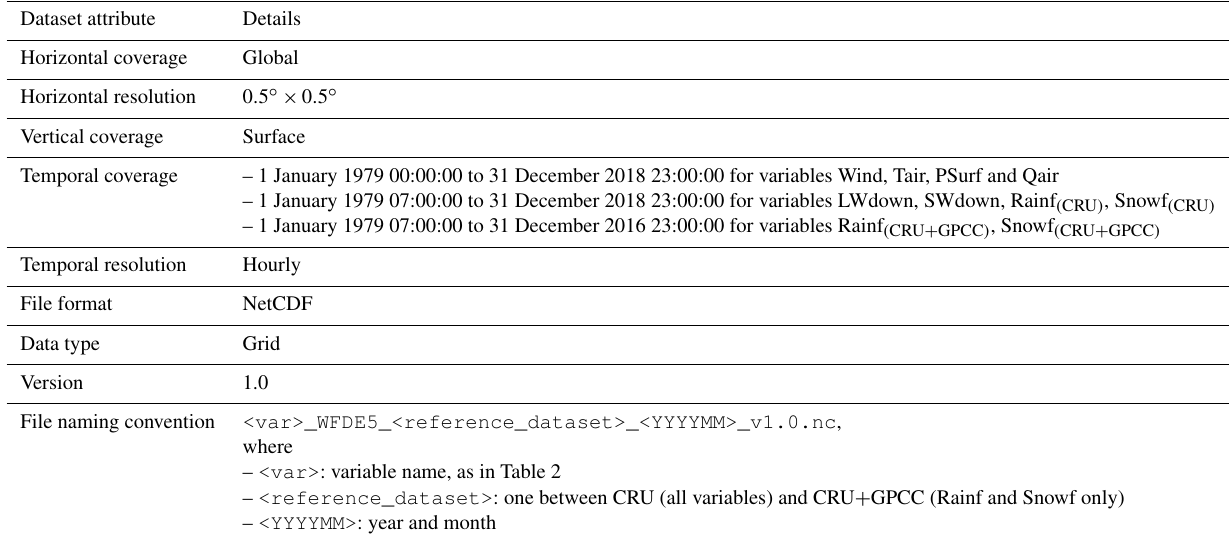
Table 3. Summary of WFDE5 dataset attributes on the C3S Climate Data